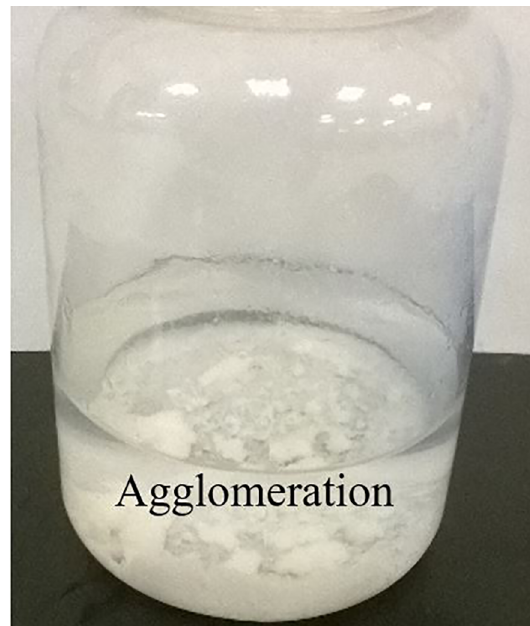
Figure 7. Agglomeration in Batch 4.